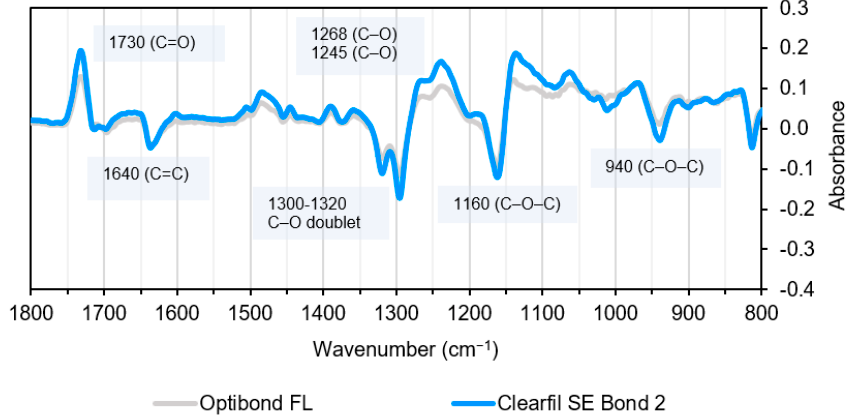
Figure 9. Absorbance changes for OBFL and CFSE, after polymerisation. Note shift of C=O stretch peak around 1700 cm − 1 to 1730 cm − 1 ; loss of a 1635–1640 cm − 1 C=C stretch peak and shift of 1300–1320 cm − 1 C–O stretch doublet to lower wavenumbers at 1268 and 1245 cm − 1 .